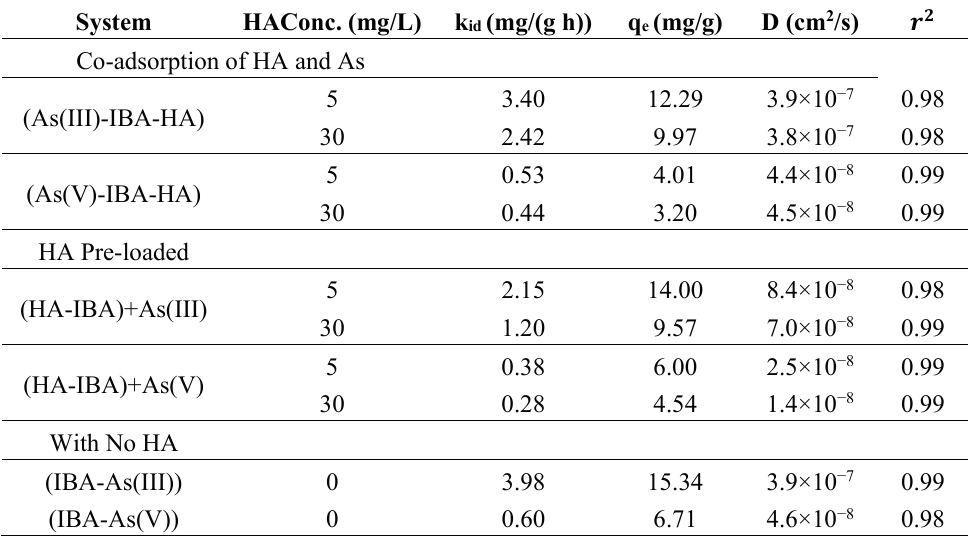
Table 2. Weber-Morris kinetic parameters of As sorption onto IBA in the presence of